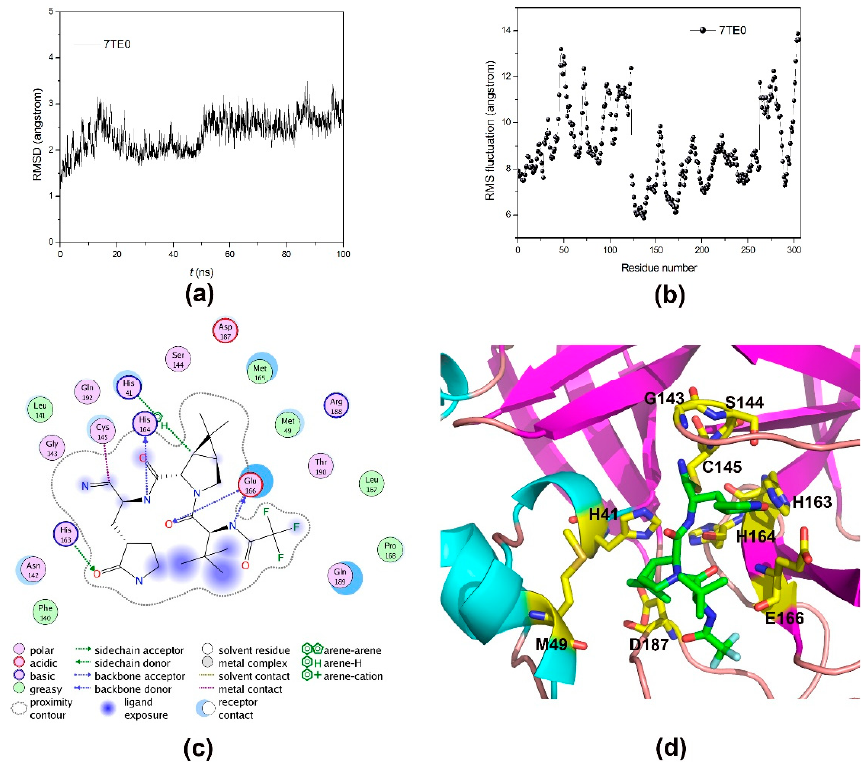
Figure 7. The MD dynamics and structure comparison of M pro -nirmatrelvir. ( a ) The RMSD values of C α atoms with respect to the first snapshots as a function of time; ( b ) The RMSF of backbone atoms versus residue number; ( c , d ) The 2D and 3D schematic representation of the interactions of averaged structure from MD simulations.